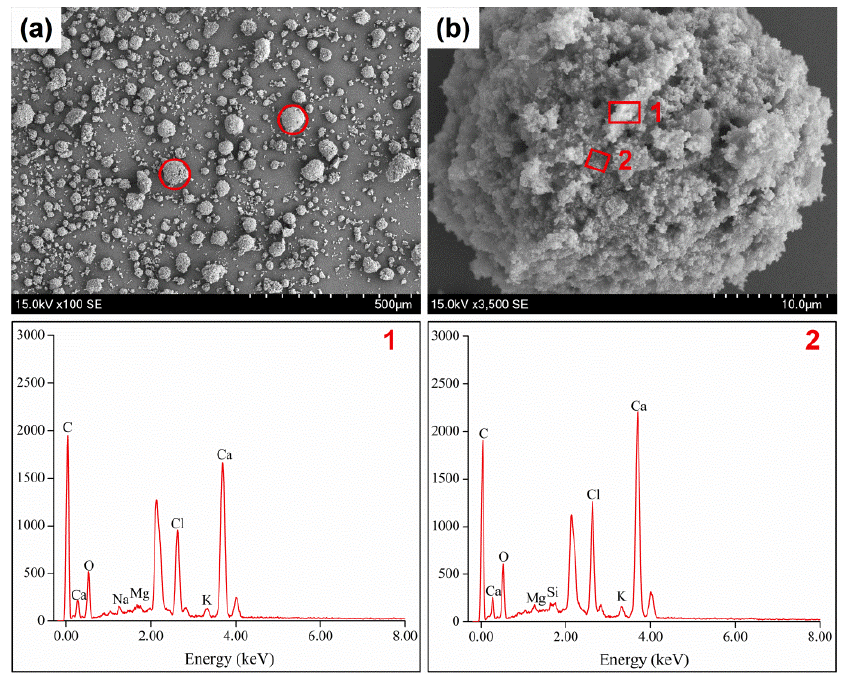
Figure 3. SEM and EDS images of RFA: ( a ) low-magnification image; ( b ) high-magnification image.